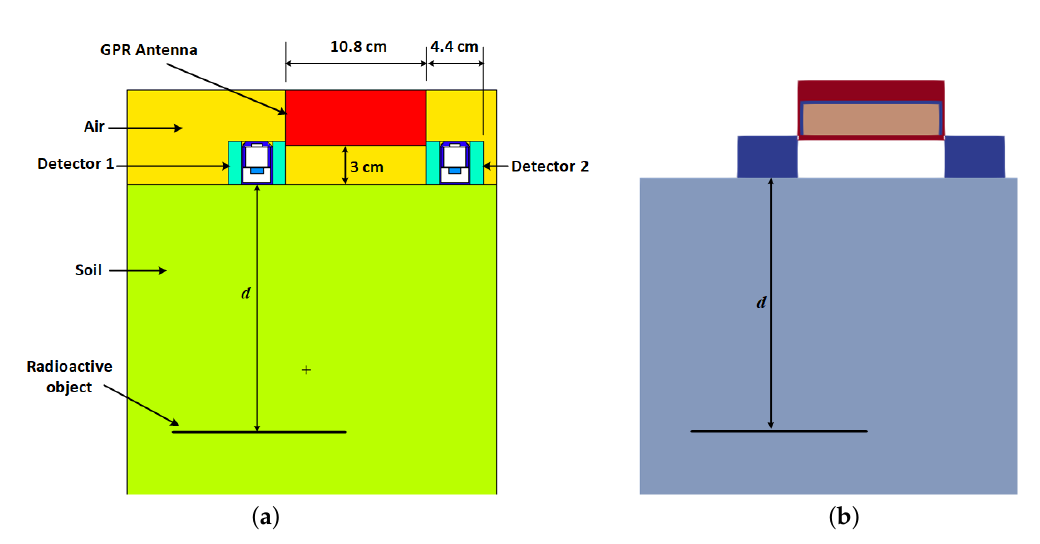
Figure 6. Model of the measurement scenario. The radioactive object is a metallic disk with Cs-137 radioactive contamination. ( a ) MCNP5 model of the measurement scenario. The gamma detectors are surrounded by 1 cm-thick lead collimators with an inner radius of 2.4 cm and height of 3.3 cm; ( b ) gprMax model of the measurement scenario. All labels and dimensions are the same as ( a